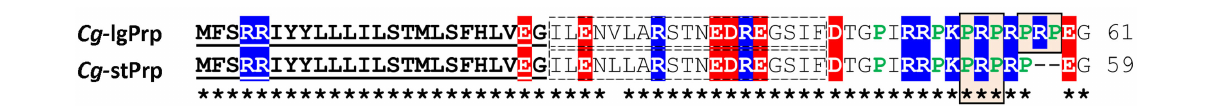
FIGURE 4 |Amino acid alignment of two sequences representative of long and short Cg -Prps. Precursors of Cg -Prps are composed of a 24-residue signal peptide (underlined) followed by a 19-residue anionic proregion (dashed box), and a 16–18 residue putative mature peptide. In long forms (referred to as Cg -lgPrps), two repeats of the Pro-Arg-Pro motif (orange boxes) are found, while in short forms ( Cg -stPrps), one motif is missing.While Pro-Arg-Pro motifs are common in proline-rich AMPs